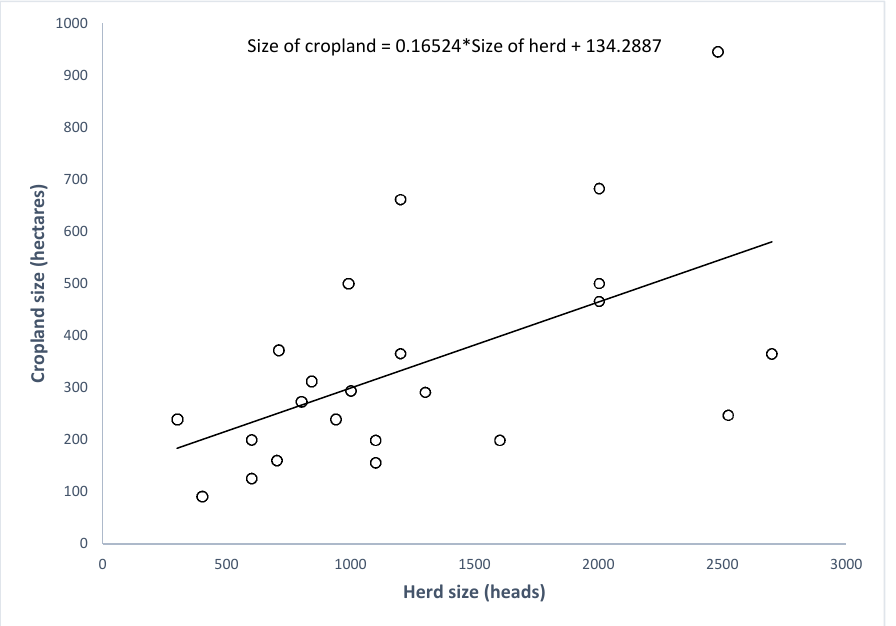
Figure 5. Correlation between herd size and cropland size. With an average herd size of 1215, the average herd size of farms with zero acreages was similar to the farms with nonzero acreages. With 3200 and 4600 total cows, two farms in this subgroup were significantly larger than the largest farm in the nonzero acreage subgroup. Similarly, 3 farms had less than 300 cows in the zero-acreage subgroup.